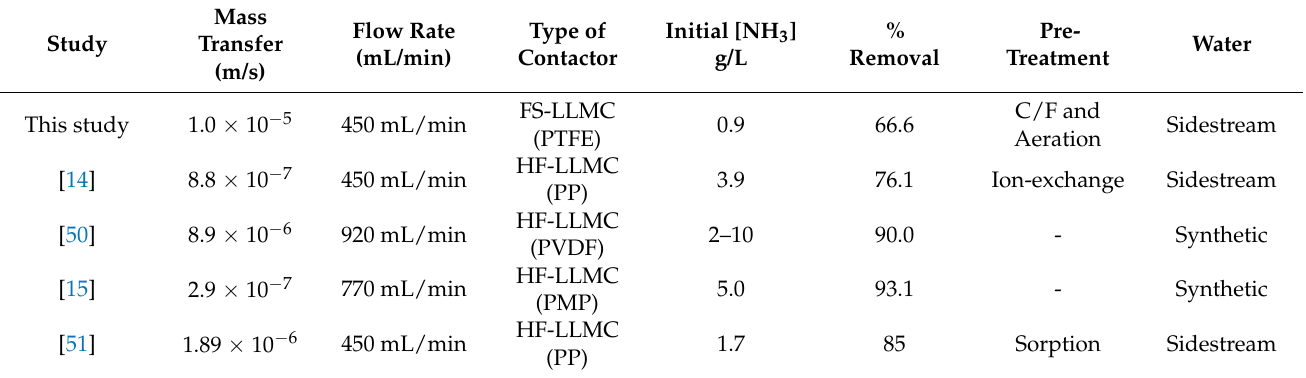
Figure 5. Membrane contactor results during operation: ( A ) TAN concentration evolution in the feed tank for pre-treated and untreated centrate, ( B ) TAN recovery and pH variation and ( C ) TAN concentration evolution and concentration factor in the acid tank. Table 8. Km values obtained in different studies with hollow fibre liquid–liquid membrane